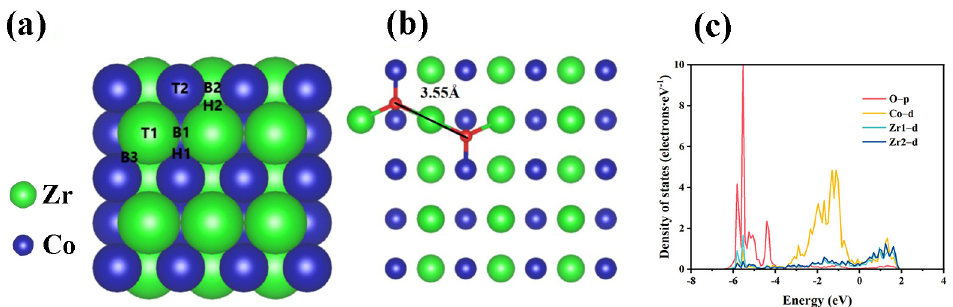
Figure 5. ( a ) Initial adsorption sites of the O 2 molecules on ZrCo (110); ( b ) top view of the B3b site; ( c ) PDOS distribution of the B3b configuration.